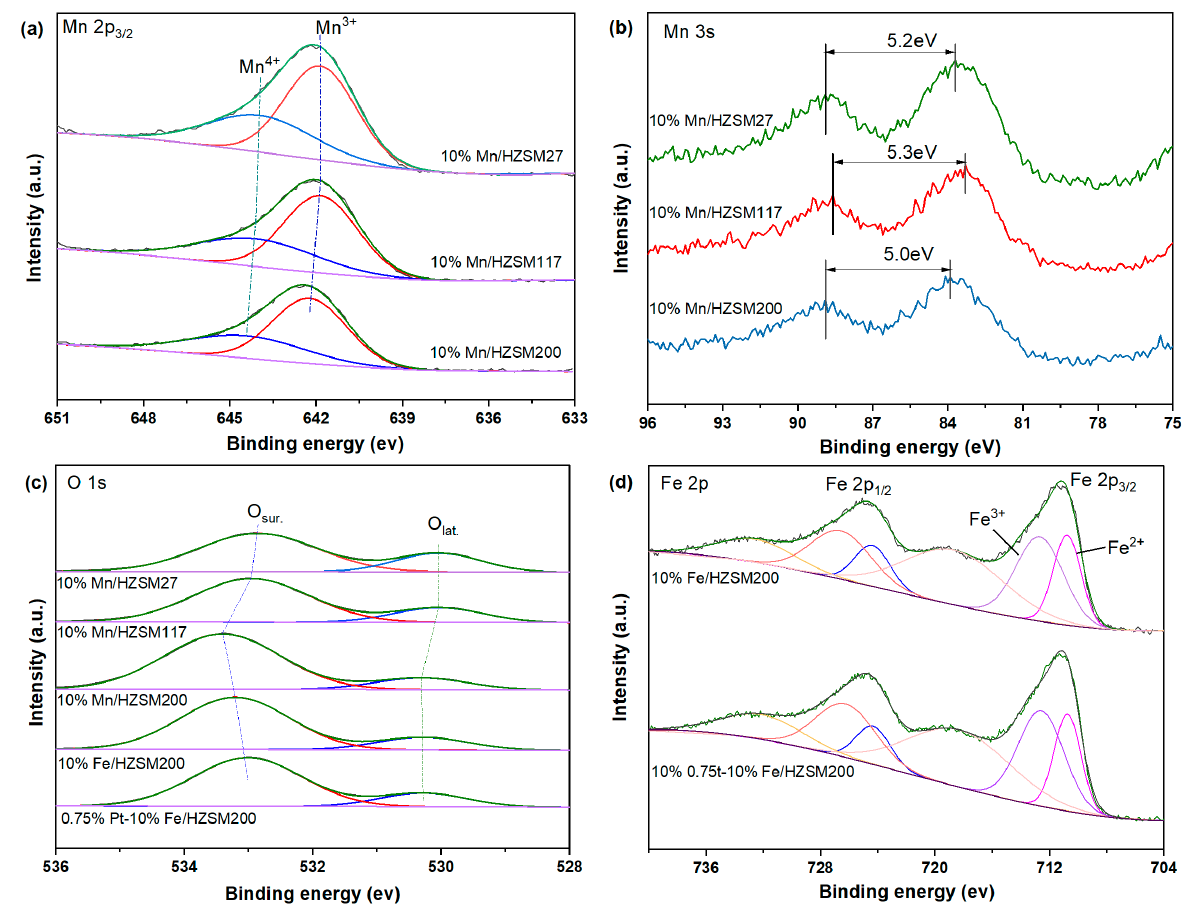
Figure 5. XPS patterns of the catalysts: Mn 2p ( a ), Mn 3s ( b ), O 1s ( c ), and Fe 2p ( d ). Table 2. Binding energy and proportion of each Mn